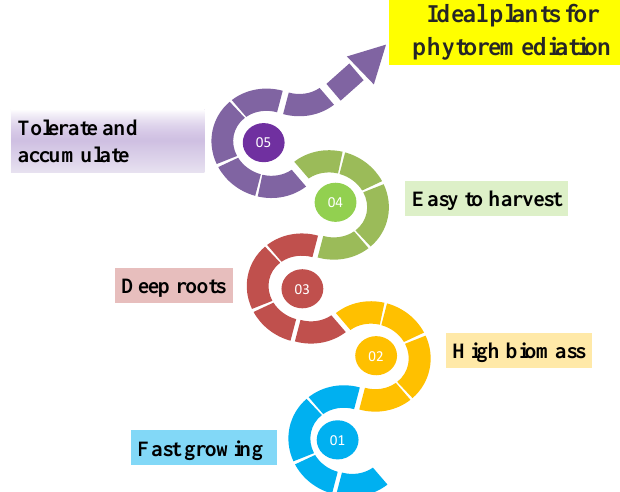
Figure 1. Characteristics of the ideal plants for phytoremediation.